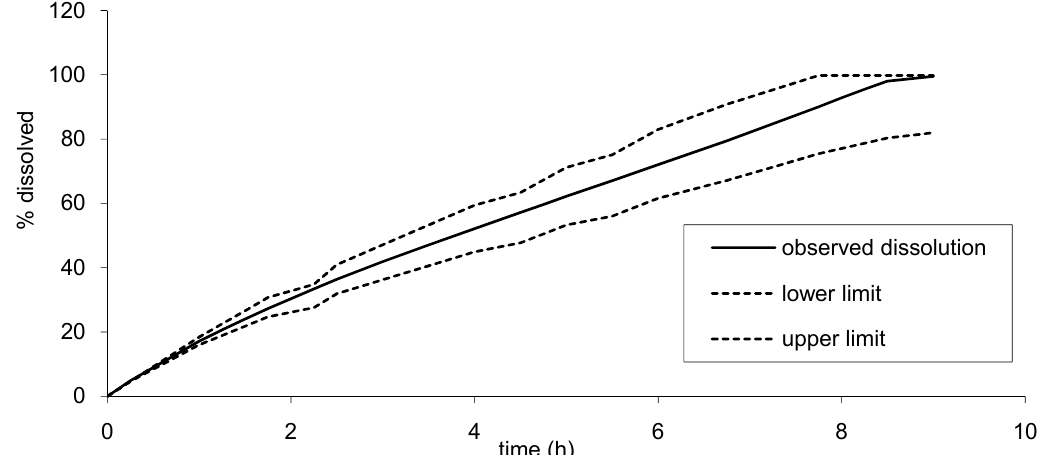
Figure 10. Dissolution limits to ensure bioequivalence to formulation B.